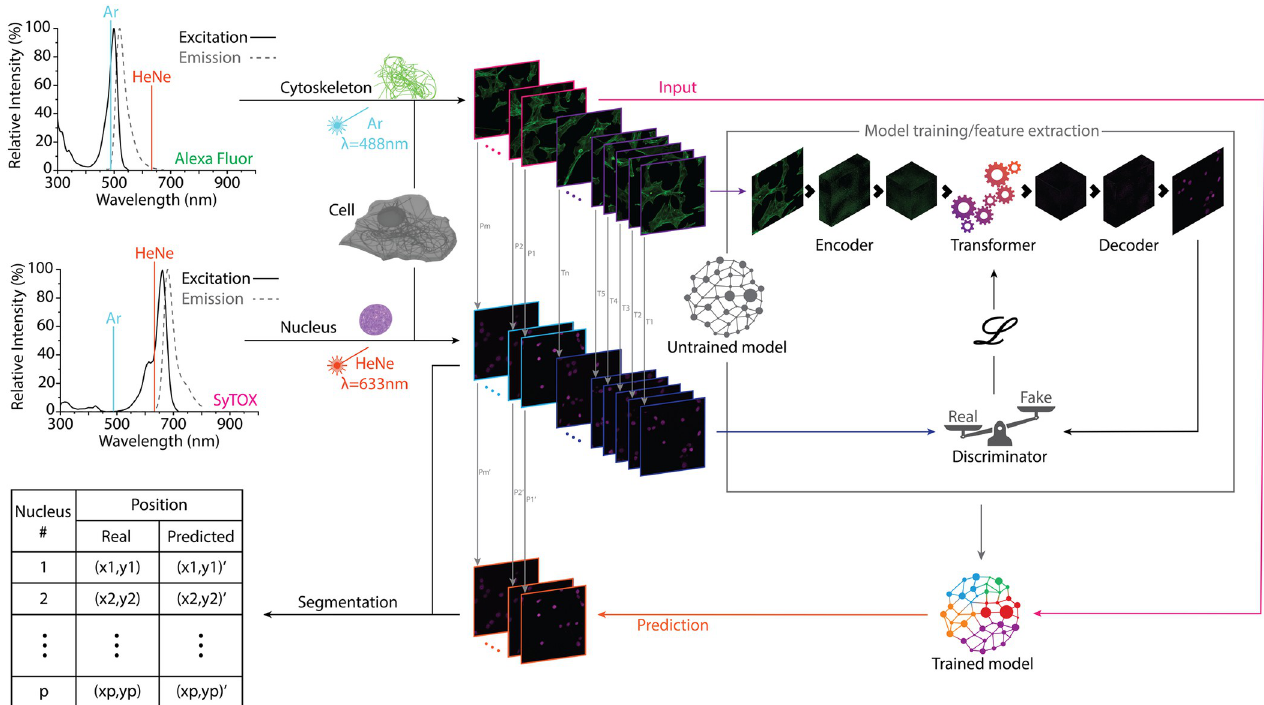
Fig 1. Demonstration of a correlation between arrangements of actin filaments and nuclear position. Actin filaments and nuclei information was isolated using non-overlapping fluorophores (Alexa Fluor 488 and SyTOX Deep Red). Then, 80% of the dataset of filaments was used as input to train a transformer- based network using the corresponding paired nuclei to evaluate the proximity to the real solution. The process iteration resulted in a fully trained network that was then used to generate the nuclei of the remaining 20% filament images of the dataset. The generated nuclei and their real counterparts were identified, and the coordinates of their centroids were determined to evaluate the network’s ability to predict the nuclear position using only actin filament arrangements.